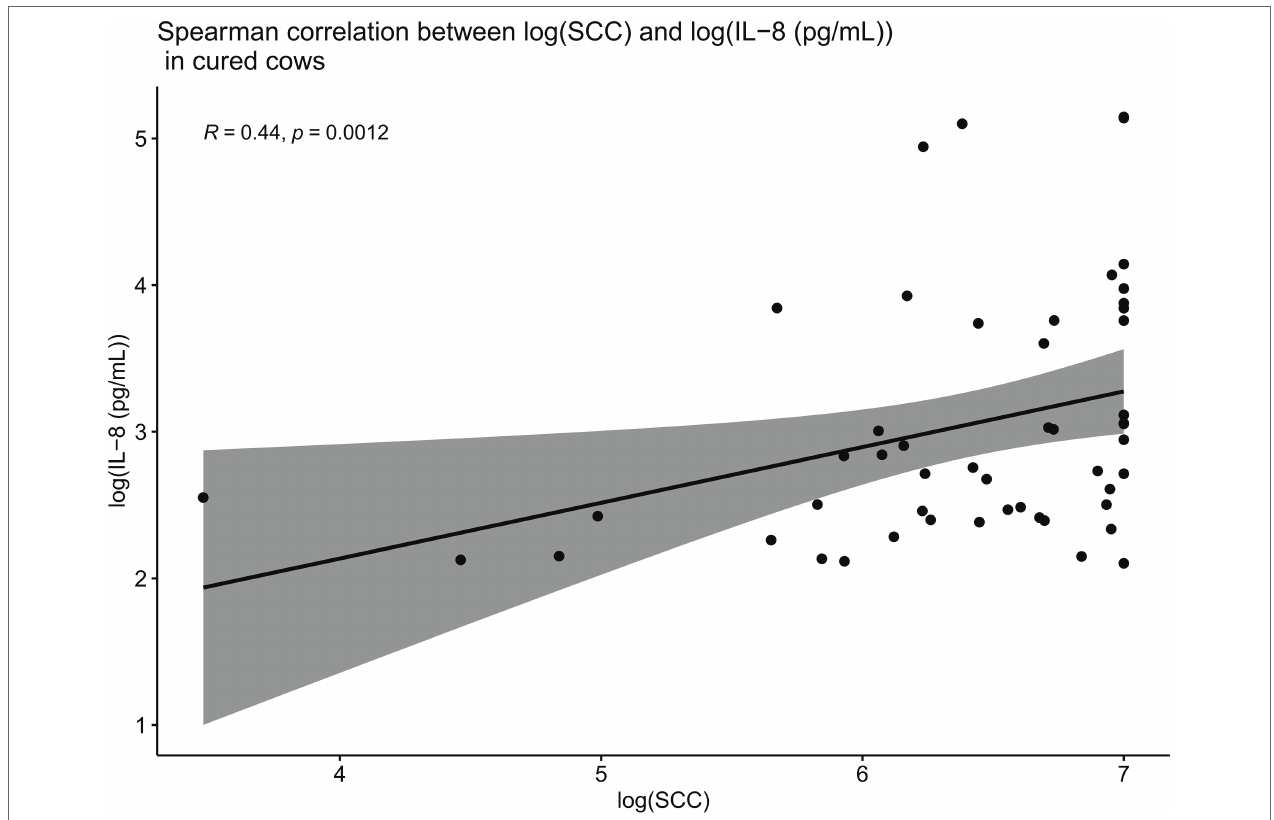
FIGURE 7 | Spearman correlations between IL-8 values and SCC values in cows which were cured showing that when compared overall, SCC and IL-8 are positively and significantly correlated in cured cows ( R = 0.44, p = 0.0012). This suggests that increased IL-8 values in response to infection (and therefore high SCC values) result in the recruitment of PMNs to the site of infection, which likely combat the offending pathogen, eventually resulting in a clinical